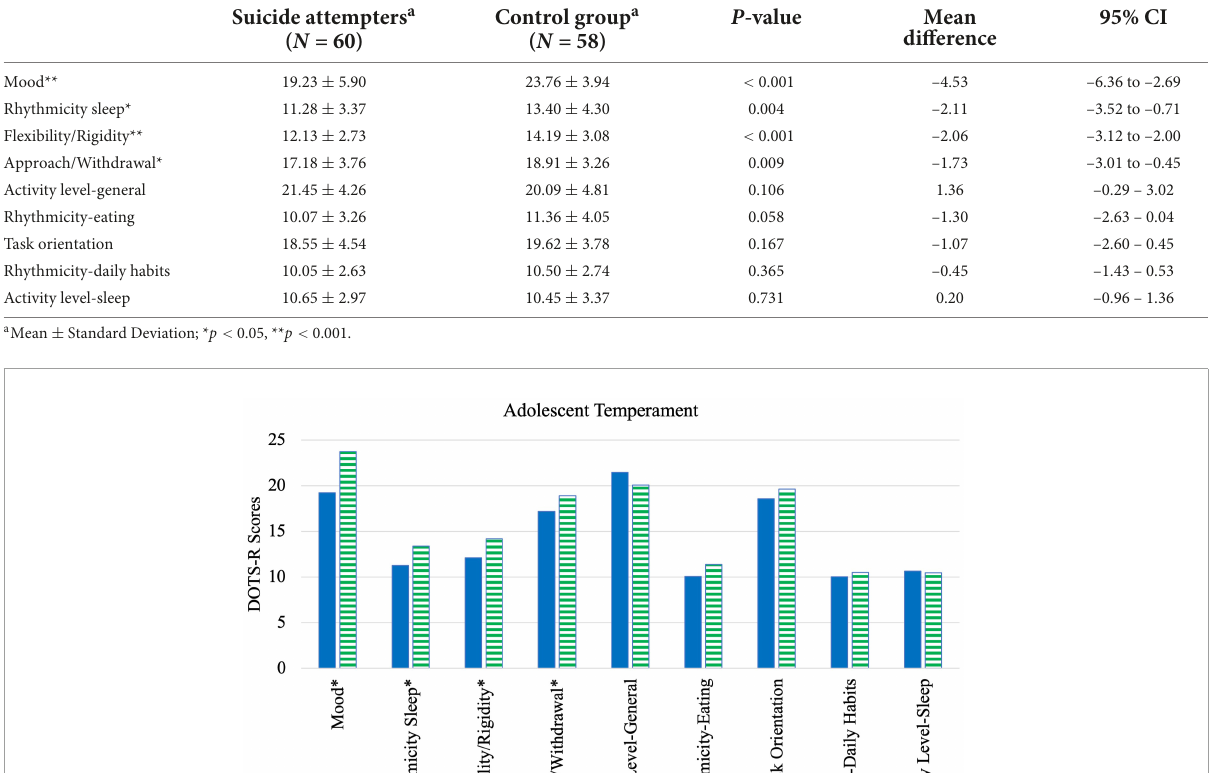
to those who were not. In this sample, however, higher general activity levels were found for male but not female suicide attempters, compared to controls, although this was only significant at p <